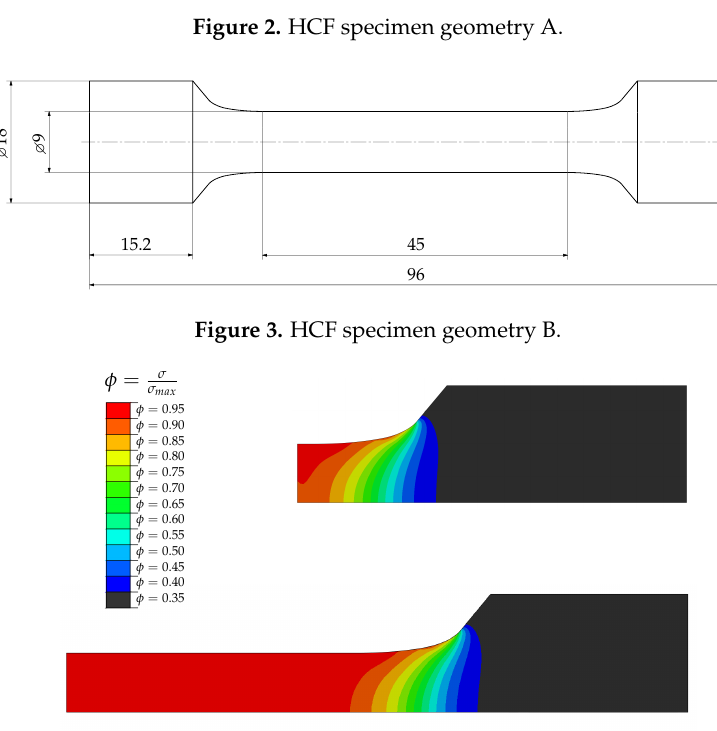
Figure 4. FEM analysis of specimen types A and